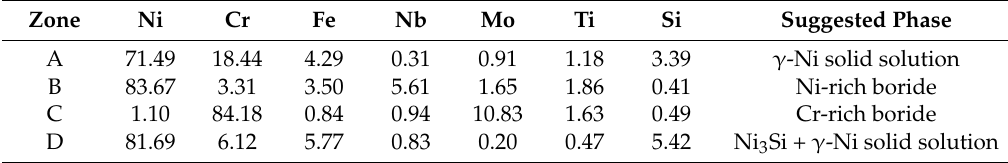
Figure 2. SEM ( a ) micrographs of the transient liquid phase (TLP) bonded GH4169/BNi-2/GH4169 at 1040 °C for 30 min; and ( b ) A magnified image of the white square in (a). Table 2. Chemical composition (wt.%) of different zones marked in Figure 2.